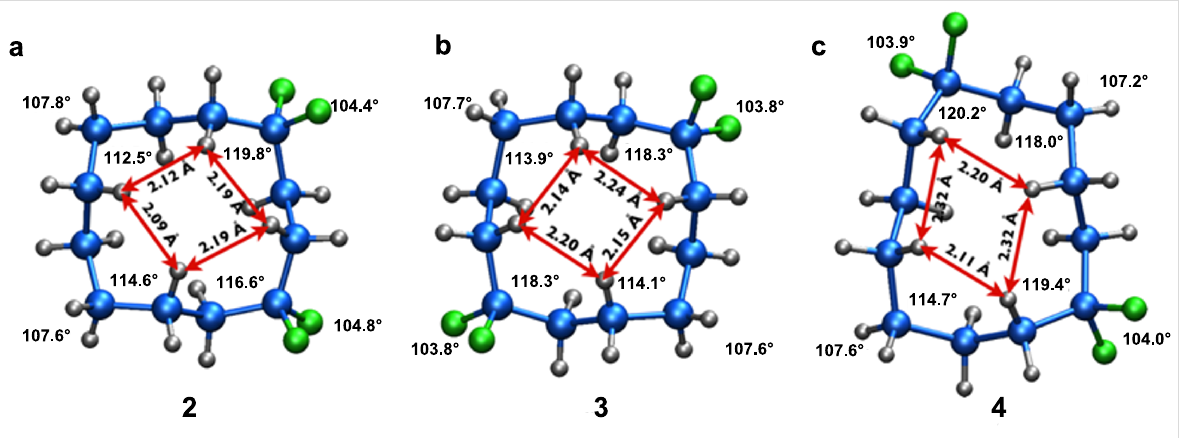
methylene (CF 2 ) groups in place of methylenes (CH 2 ) [7]. The study revealed that the CF 2 groups always occupied corner positions. This was deduced by a combination of 19 F NMR, X-ray structure analysis and theory studies. Two reasons emerged for this. Firstly, if a C–F bond did project into the ring ( endo ), then the increased size of the fluorine atom relative to hydrogen increases the transannular 1,4-H,F relative to 1,4-H,H strain, by placing a fluorine in the square of hydrogen atoms on the top (or bottom) face of the ring. Secondly, the electronega-